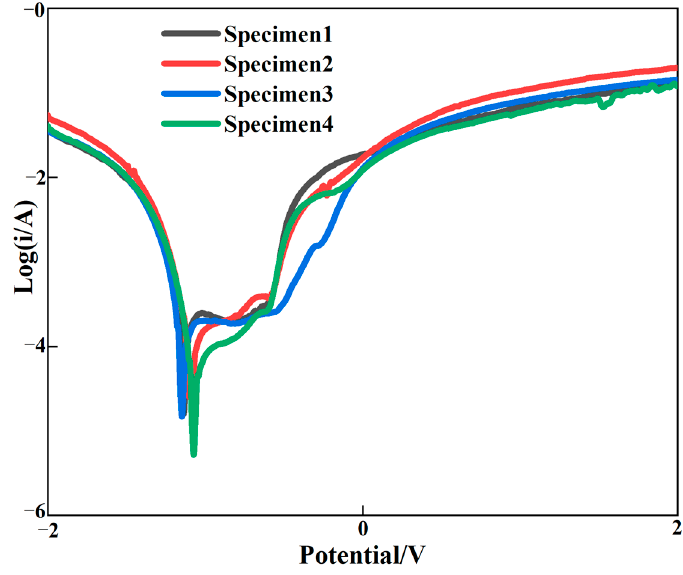
Figure 10. Polarization curve of the cladding layer. Table 5. Self-corrosion voltage and self-corrosion current density of the cladding layer.